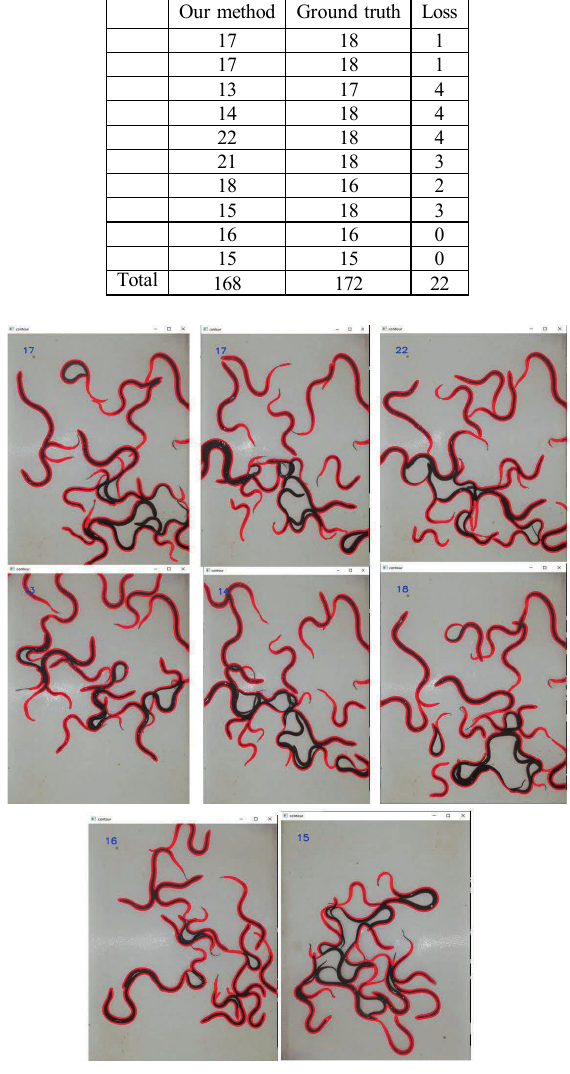
Fig. 13. Some illustrations of counting